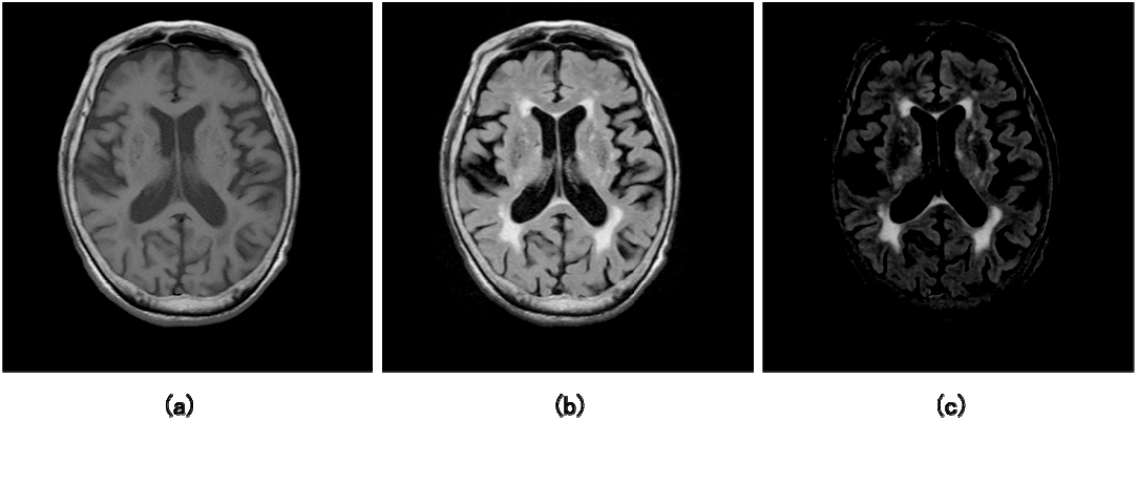
Figure 12. Illustrations of (a) an original T1-weighted image, (b) an original fluid- attenuated inversion-recovery (FLAIR) image with hyperintense regions, (c) a subtraction image between the FLAIR image and T1-weighted image